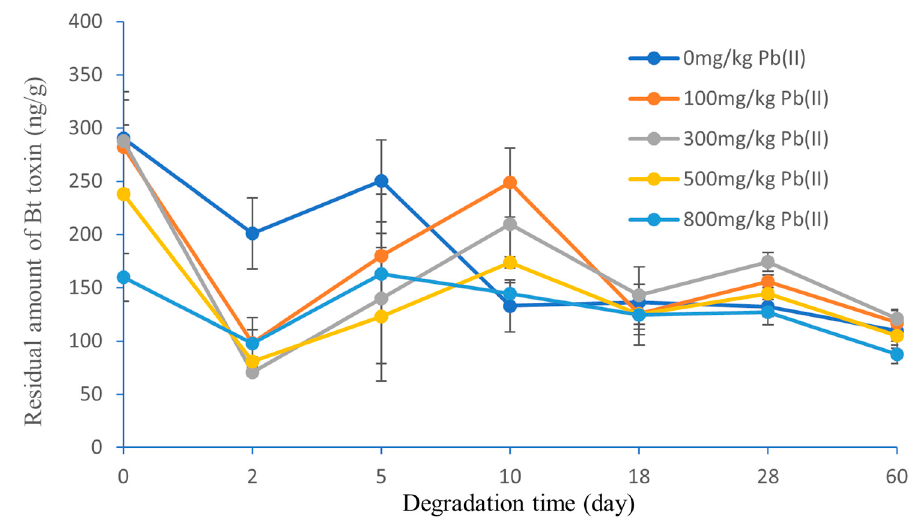
Figure 7. Effect of Pb(II) concentration on the degradation of Bt toxin in black soil.